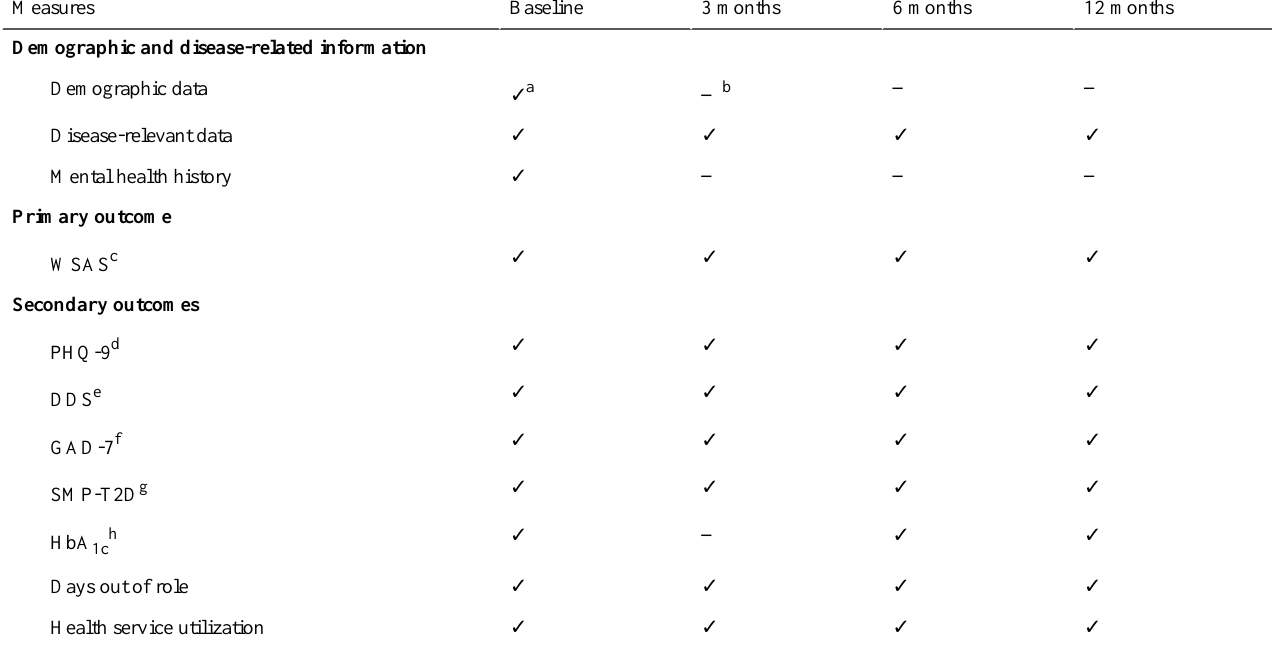
Table 1. Measures obtained at each assessment